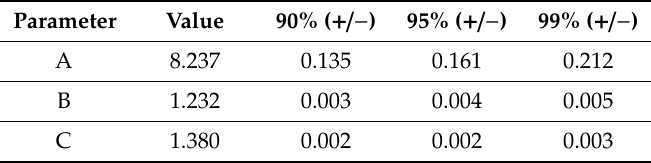
Table 2. Values of the parameters of ETMEA